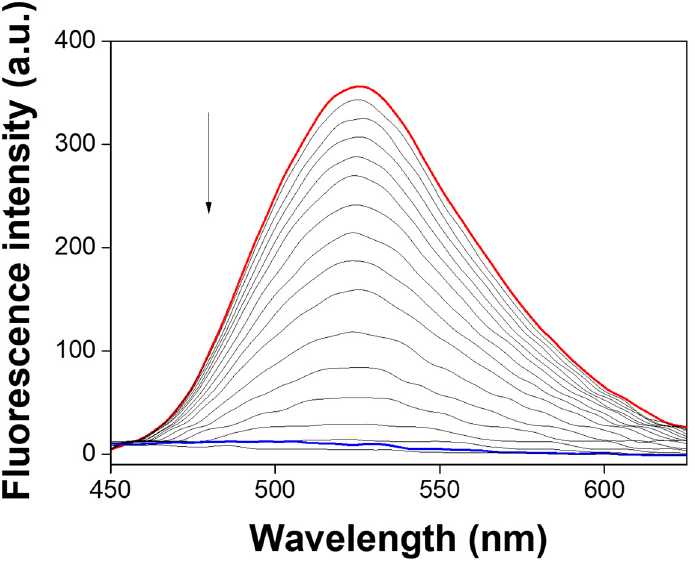
Figure 8. Fluorescence titration of NATB -Al 3+ (30 μ M) with various amounts of H 2 PO 4 − (0–1.5 equiv) in MeOH.